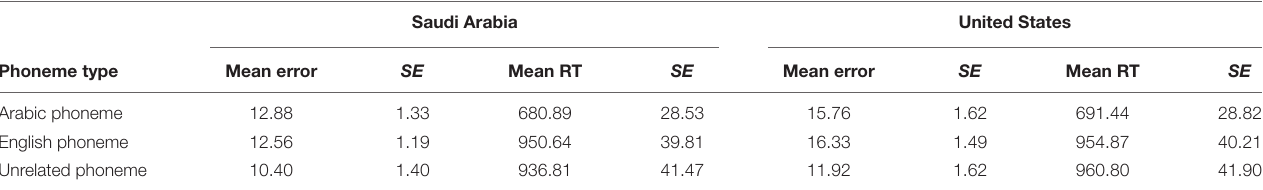
TABLE 2 | Mean error rates in percent and response times in milliseconds for Arabic–English bilinguals tested in Saudi Arabia ( n = 50) and the United States ( n = 40) by condition in Experiment 1. Saudi